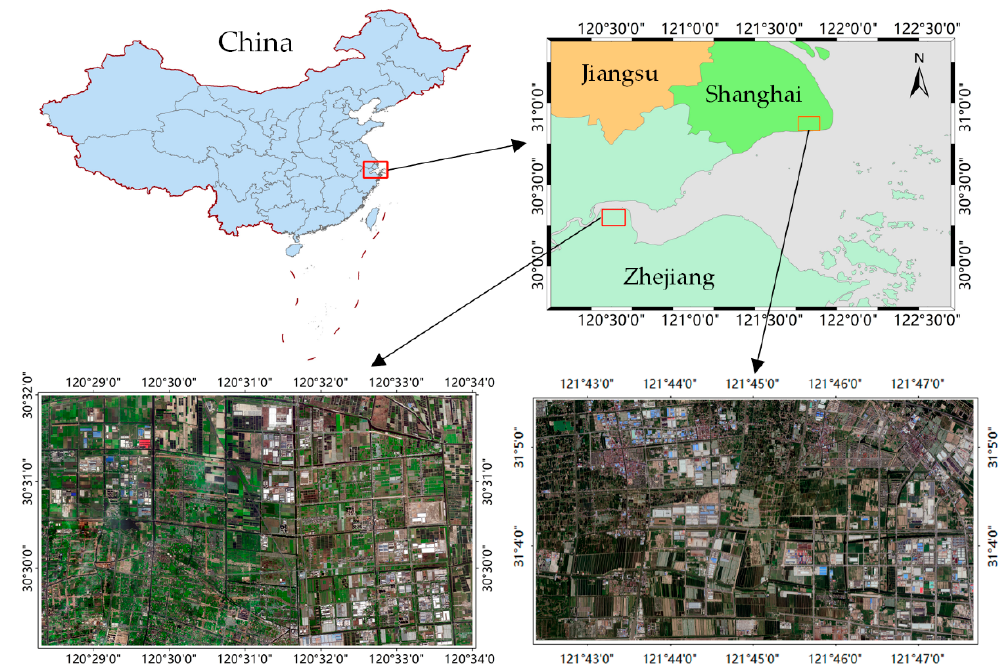
Figure 4. Overall presentation for our coastal datasets with respect to source locations and high-resolution remotely sensed images.